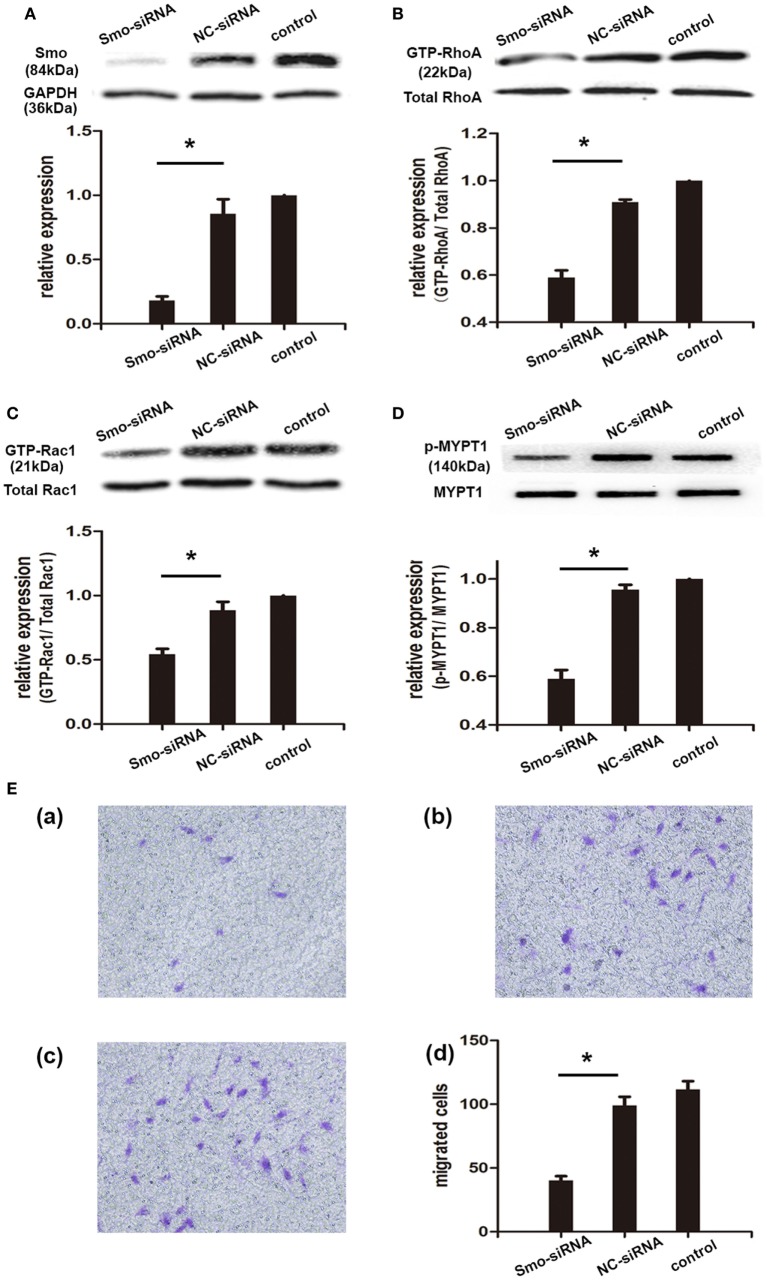
Knockdown of Smo mediated by siRNA decreased rheumatoid arthritis (RA)-fibroblast-like synoviocytes (FLSs) migration and RhoGTPase signaling. RA-FLSs were cultured and transfected with small interfering RNAs directed against Smo (Smo-siRNA) or with a negative control siRNA (NC-siRNA) for 48 h. Silencing efficiency was measured by Western Blot analysis (A). The activation of RhoA and Rac1 was detected by pull-down assays (B,C). Expression of MYPT1 was detected by Western Blot analysis and the levels of phospho-MYPT1 were normalized to expression of total MYPT1 (D). Cell migration was evaluated using Transwell assays and the numbers of migrated cells were calculated (×104 cells/ml) (E). Representative images of RA-FLSs migration after being transfected small interfering RNAs directed against Smo (Smo-siRNA) [(E), a], a NC-siRNA [(E), b], or vehicle [(E), c] were displayed (100 magnifications). The results are the mean ± SD of three independent experiments. *P < 0.05 versus control group. MYPT1, myosin phosphatase targeting subunit 1.